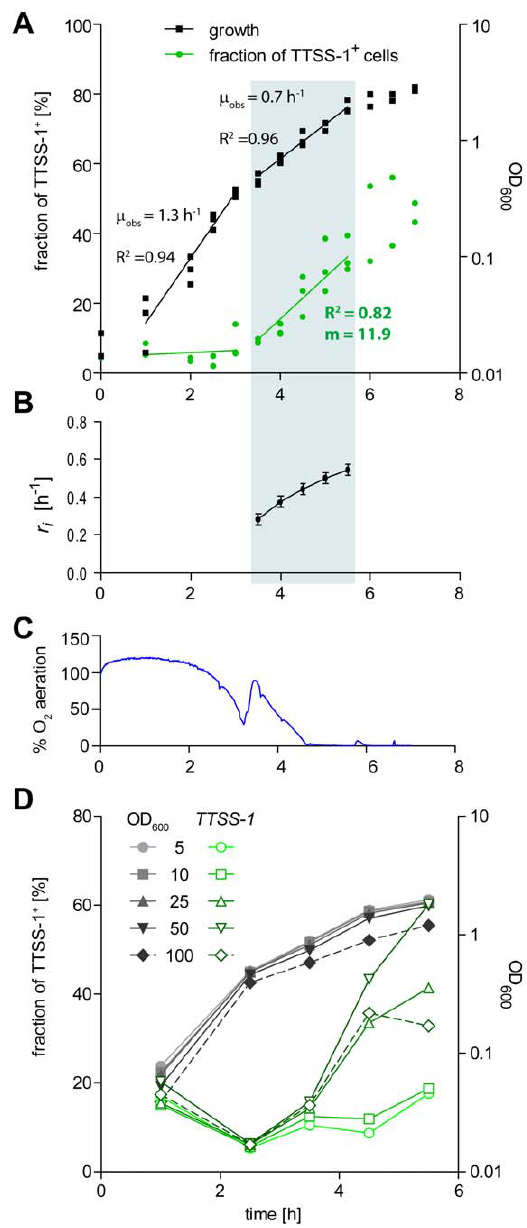
Figure 3. Time course experiment analyzing the initiation of ttss-1 expression. A) Wt S . Tm (SL1344, p sicA - gfp ) was